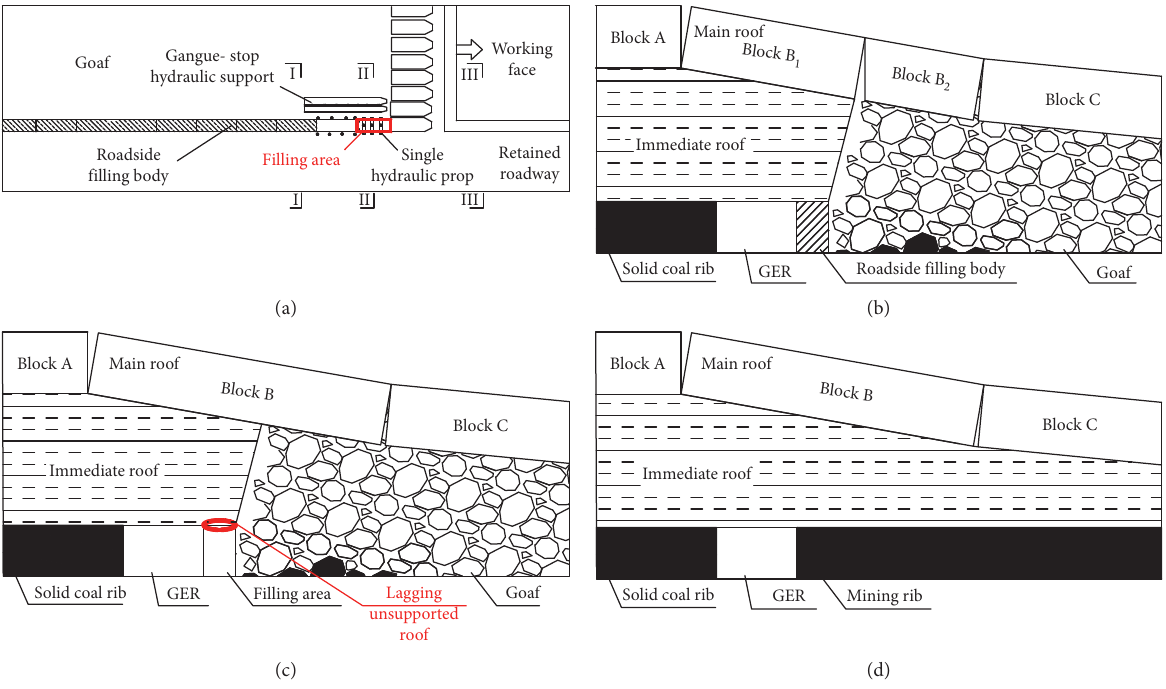
Figure 1: Sketch of lagging unsupported roof in GER-RF: (a) plan view of GER-RF, (b) section view of I-I, (c) section view of II-II, and (d) section view of